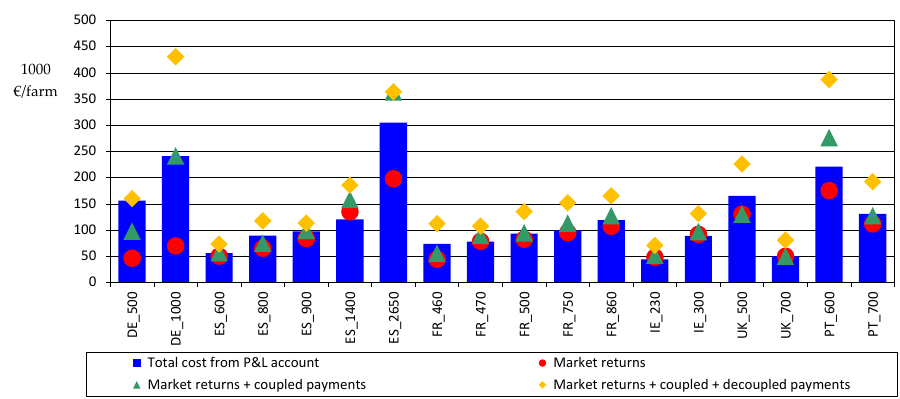
Figure 5. Whole farm profitability (1000 € / farm). Source: model results.